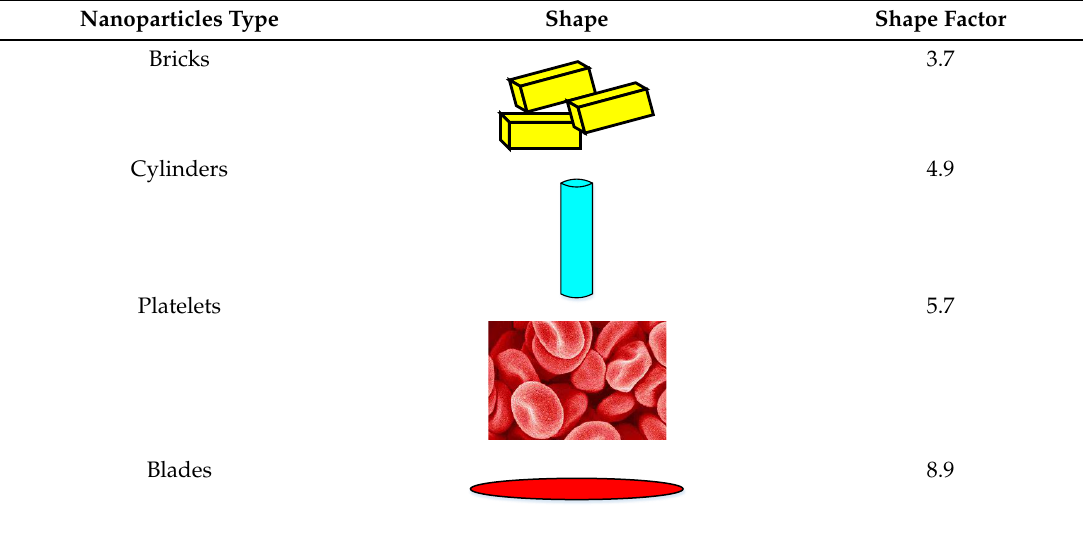
Table 2. Nanoparticles shape with shape factor [47,48]